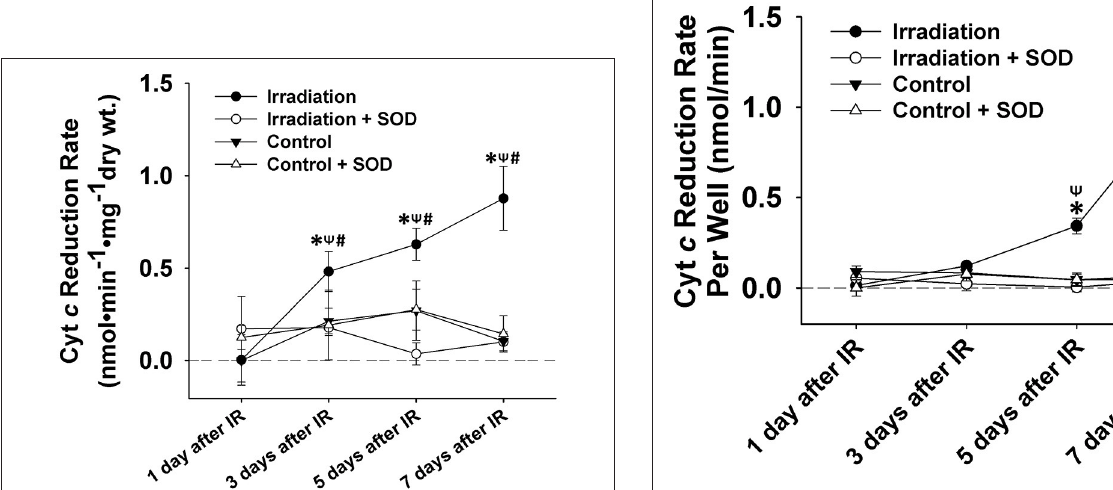
Frontiers in Physiology |